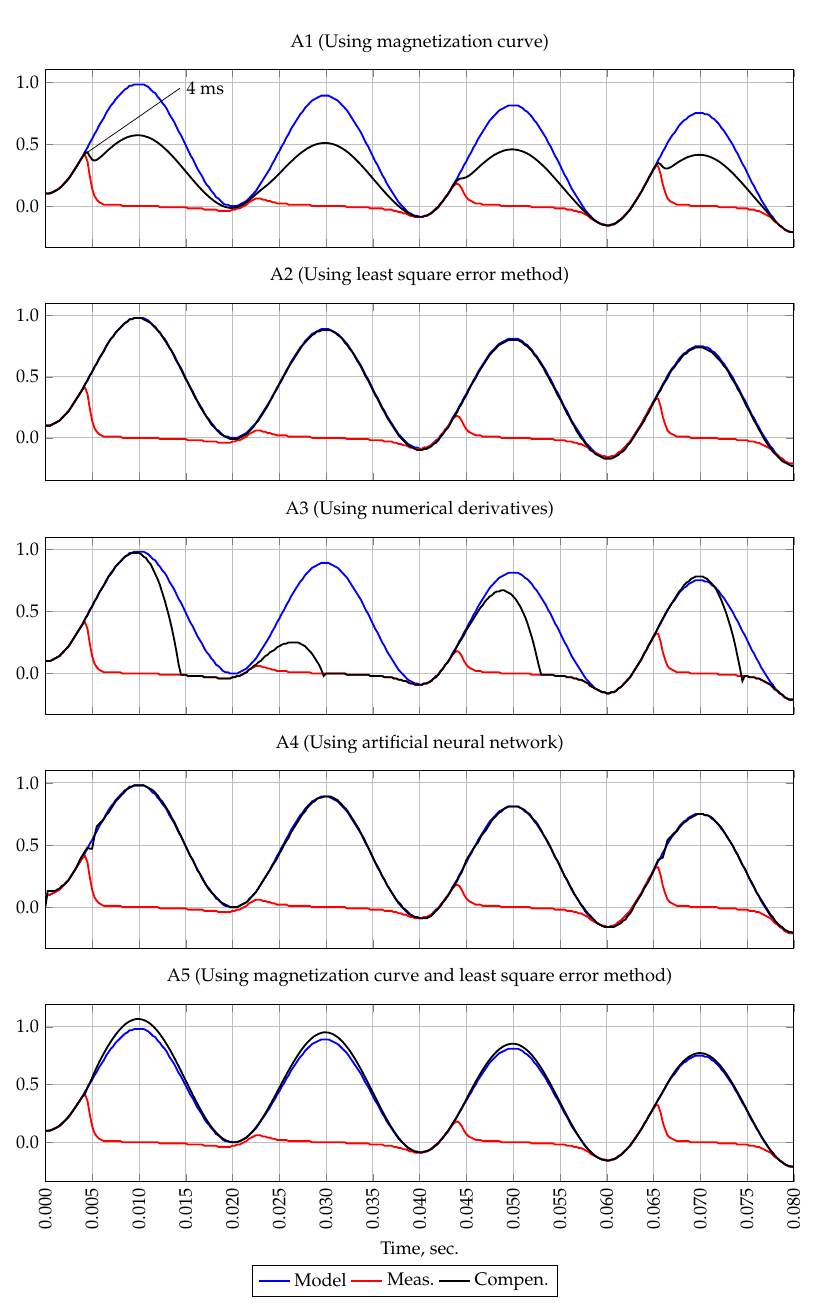
Figure 5. Oscillogram of currents, experiment 2